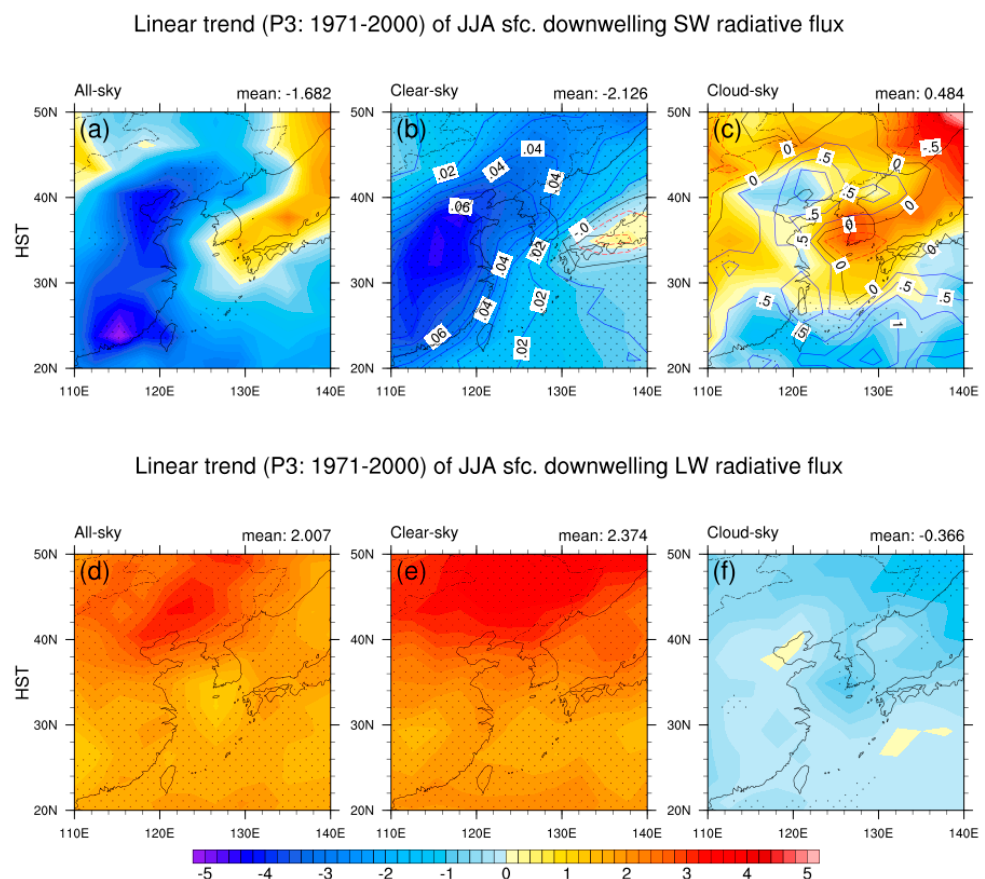
Figure 9. The linear trends of the JJA mean downwelling SW (upper panel, shading) and LW (bottom panel, shading) radiative flux at the surface (Wm − 2 decade − 1 , positive downward) according to cloud condition in the late 20th century (1971–2000); ( a , d ) all-sky; ( b , e ) clear-sky with total aerosol optical depth trend (contour in upper panel, positive solid line); ( c , f ) cloudy-sky with total cloud fraction trend (contour in upper panel) in HST. The dotted areas indicate that the trends are statistically significant at 10% level. The domain average has been shown in the right corner. Table 6. The land-mean linear trend (Wm − 2 decade − 1 ) of the JJA-mean downwelling SW, LW, and the net radiation at the surface from the HST, AER, GHG, and NAT simulations for P3. The numbers in the parenthesis are the corresponding values for the clear-sky and cloudy-sky condition.